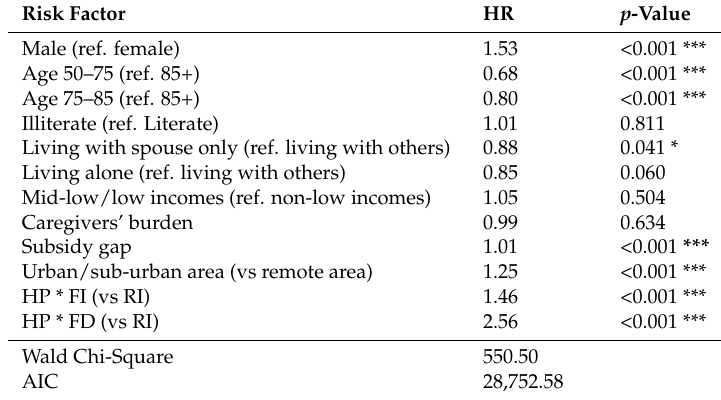
Table 3. The potential risk factors for mortality in two